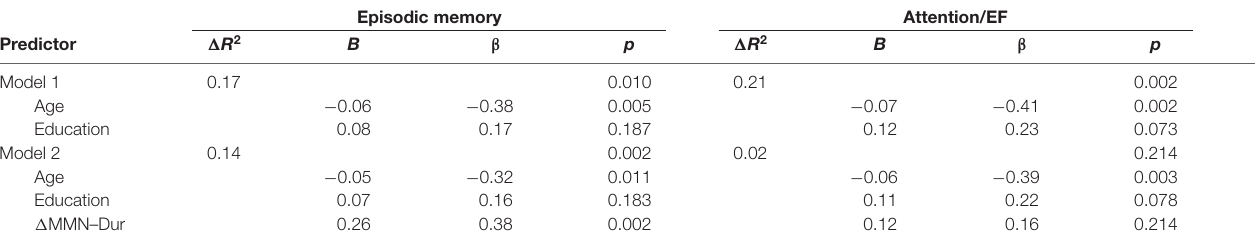
TABLE 3 | Baseline associations between auditory memory trace decay and episodic memory as well as executive functions accounting for age and education.